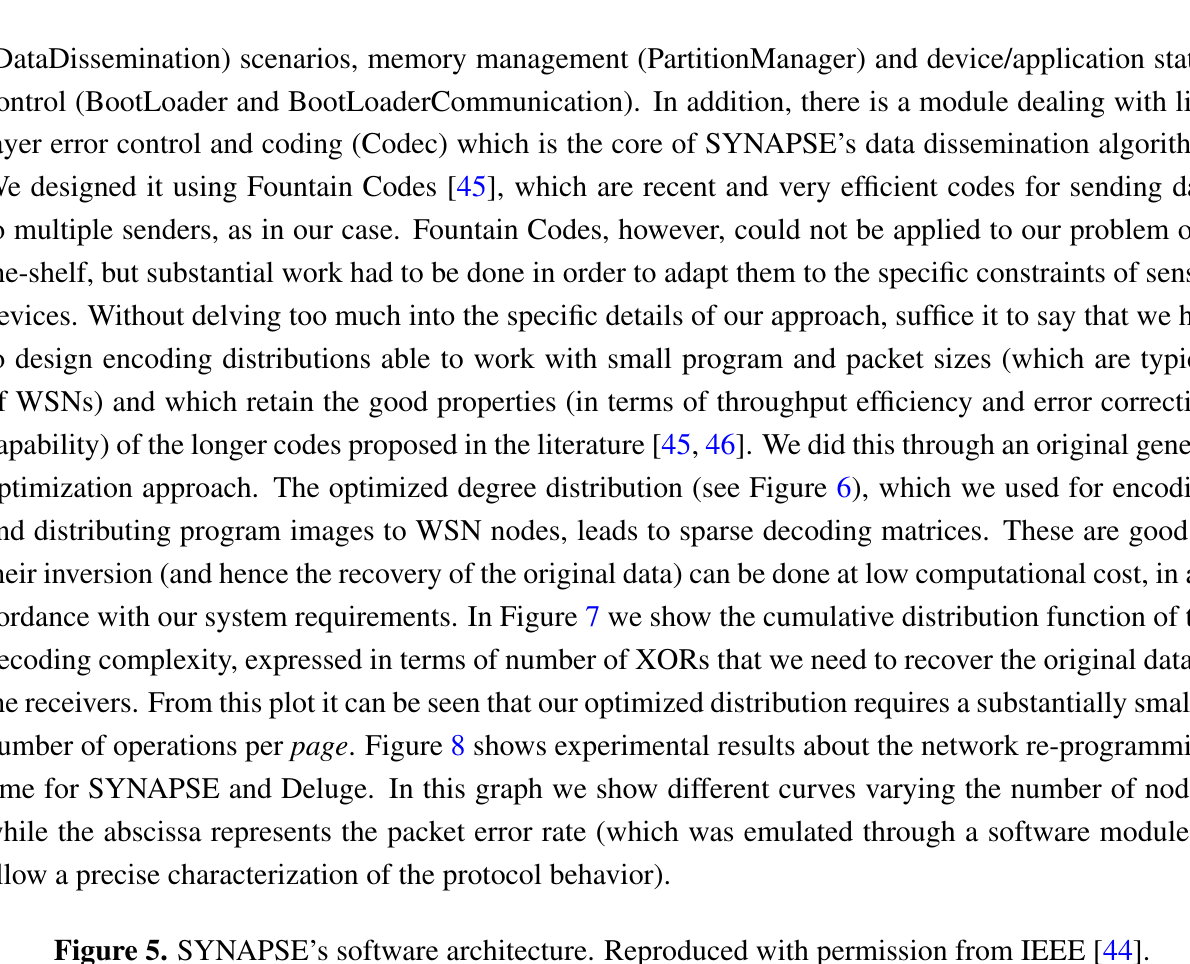
Figure 5. SYNAPSE’s software architecture. Reproduced with permission from IEEE [44].